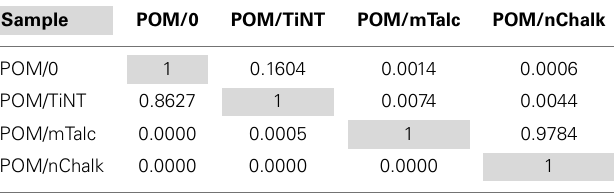
Table 2 | Statistical comparison ofAvrami parameters ( n , τ ) from PLM data fitting .